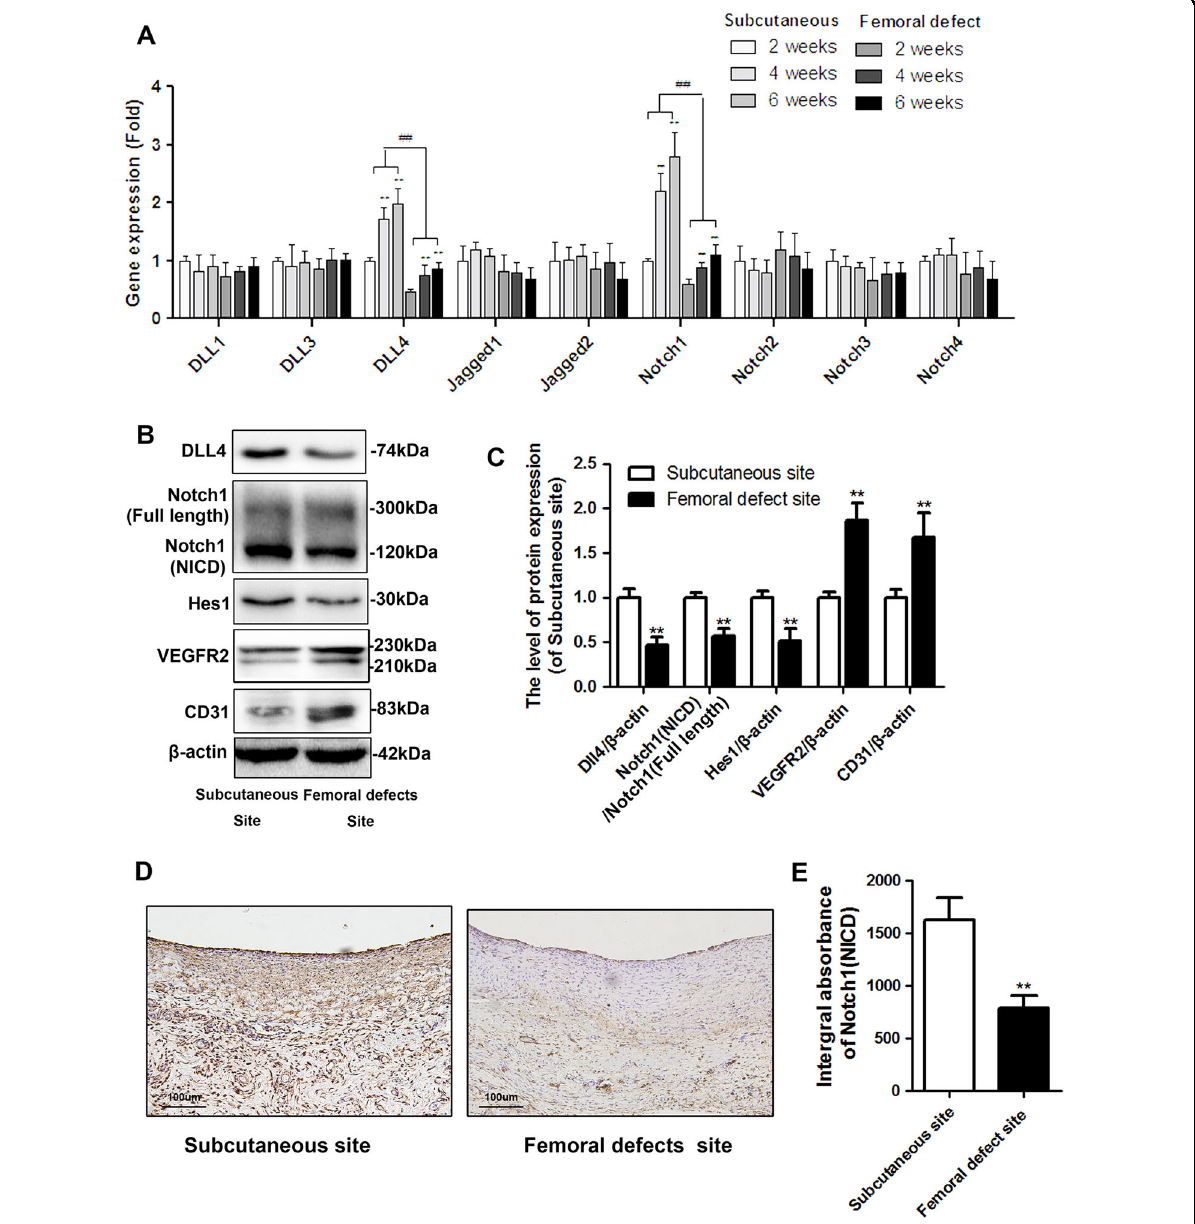
Fig. 3 The Dll4/Notch1 pathway in the induced membrane in the subcutaneous site and femoral defect site after 6 weeks of surgery. a The mRNA expression levels of 9 ligands or receptors involved in Notch signaling (ligands: Dll1, Dll3, Dll4, Jagged1 and Jagged2; Receptors: Notch1, Notch2, Notch3 and Notch4) were screened by qRT-PCR in induced membrane, which formed in the subcutaneous site and femoral site at 2, 4, and 6 weeks (** P < 0.01, vs. 2-week induced membrane in the subcutaneous site and femoral defect site, respectively, ## P < 0.01, vs. the same time point for the induced membrane in the subcutaneous site). b – c The protein expression of Dll4, Notch1 (NICD), Hes1, VEGFR2, and CD31 in induced membrane derived from the subcutaneous site and femoral defect site. d – e Immunohistochemistry staining of Notch1 (NICD) in induced membrane derived from the subcutaneous site and femoral defect site (scale bar: 50 μ m). The data in the fi gures represent averages ± S.D. Signi fi cant differences between the different groups are indicated as ** P < 0.01, compared with induced membrane in the subcutaneous site; for each group, n =